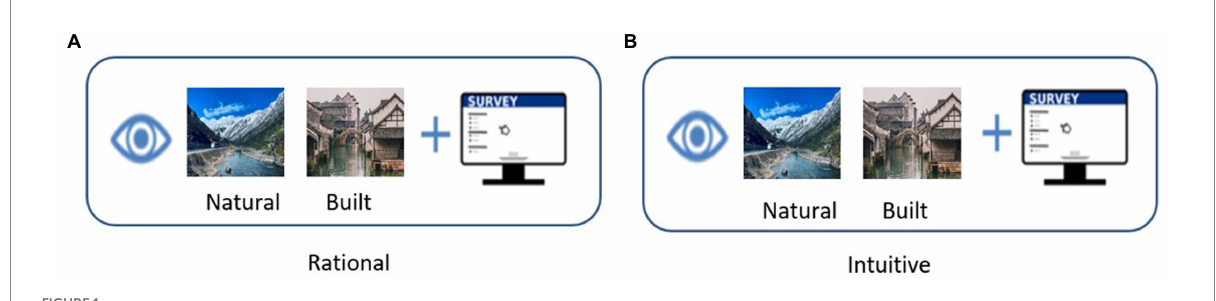
FIGURE 1 Procedure for eye-tracking research. J_usti. 2019 “Share a view from a previous trip with friends” Weibo, April 14, 2019 (https://weibo. com/5235197084/HpE4pnYlV). Reproduced with permission. Traveling_Lover. 2019. “Beautiful!” Weibo, April 12, 2019 (https://weibo. com/2628053771/HpkBrsp4m). Reproduced with